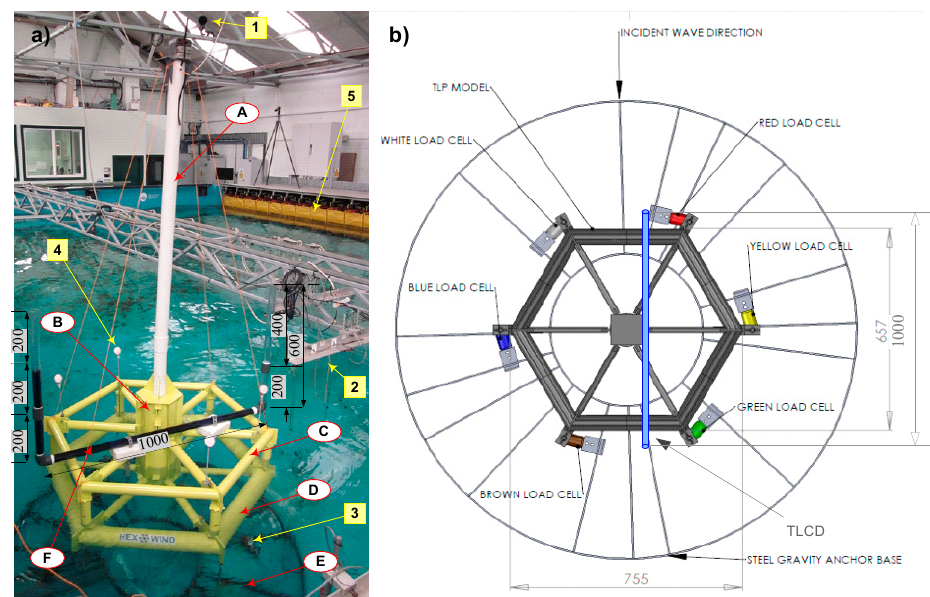
Figure 21. Example of TLP testing. ( a ) 1:50 scale model of truss-type TLP platform experimental setup: (A) mast, (B) central column, (C) upper structure, (D) buoyancy ring, (E) gravity base, and (F) TLCD. The locations of devices used: (1) motion camera, (2) wave probes, (3) load cells, (4) reflective motion markers, and (5) flap-type wave-maker; ( b ) TLP view from above: position of TLCD and gravity base with load cell arrangement in relation to the incident wave direction (reproduced from